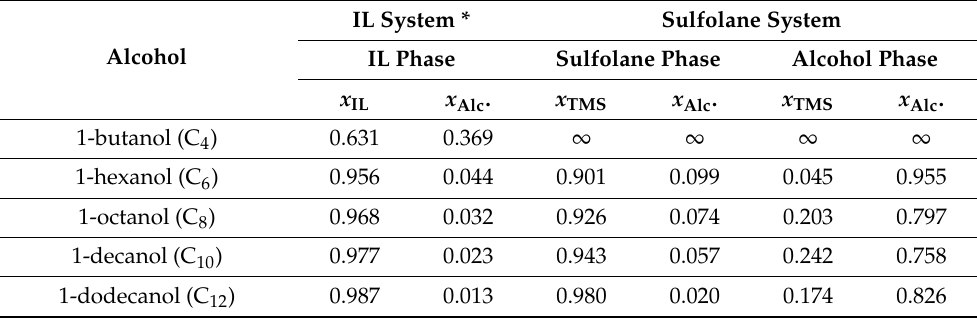
Table 1. Mutual miscibility expressed in mole fraction units of selected 1-alcohols (Alc.) with 1-